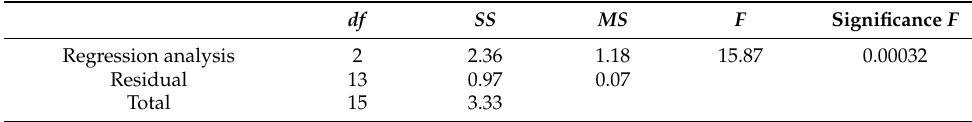
Table 9. Results of variance analysis.